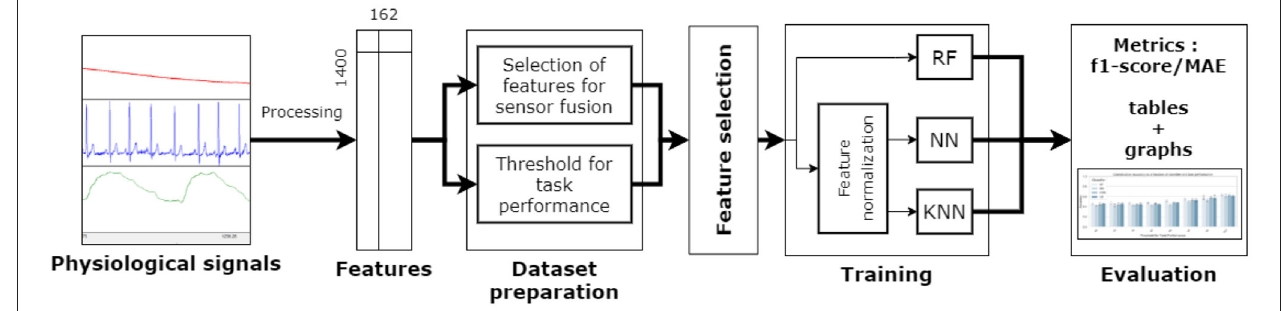
FIGURE 5 | Procedure employed for the classification and regression tasks. RF, Random Forest; NN, Neural Network; KNN, k-Nearest